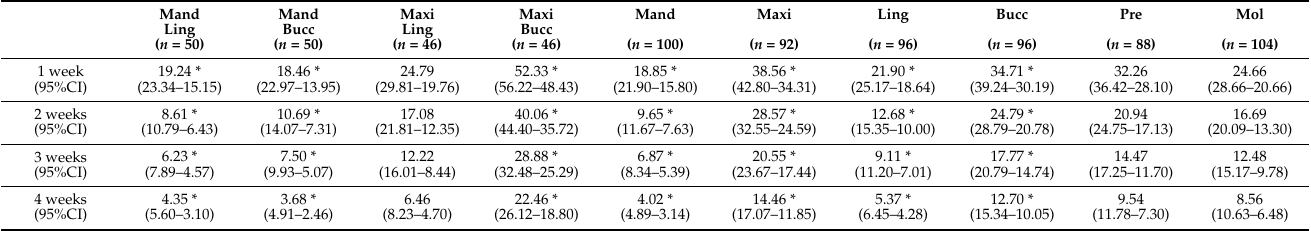
Table 5. The average Bio Coat Ca adhesion rate (%) by the